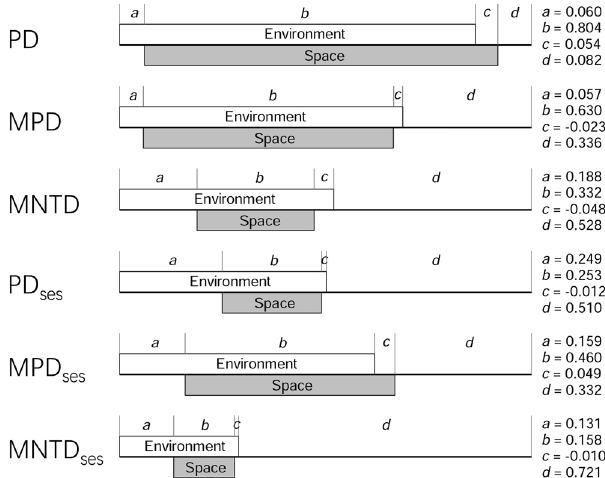
Figure 3. Results of partial regression analyses partitioning the variation in each phylogenetic metric into four portions: ( a ) uniquely accounted for by environmental variables, ( b ) accounted for jointly by environmental and spatial variables, ( c ) uniquely accounted for by spatial variables, and ( d ) unexplained variance. For each phylogenetic metric, environmental and spatial variables included in the partial regression analyses are shown in Tables 2 and